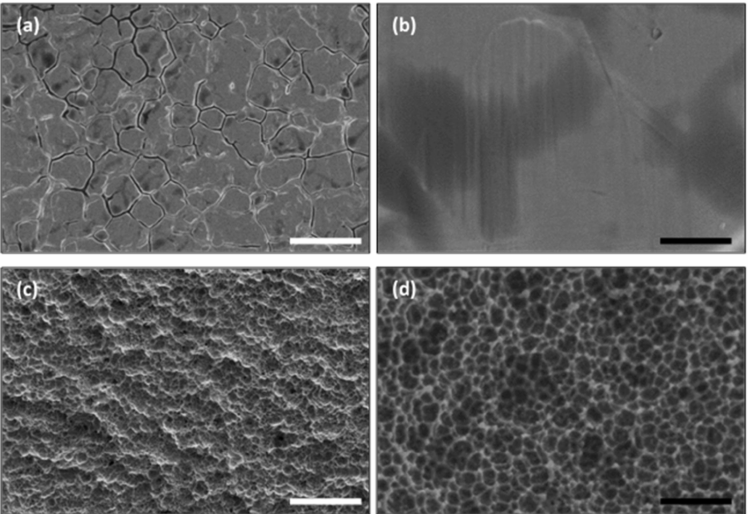
Figure 2. FE-SEM micrographs of bare stainless steel ( a , b ) and stainless steel electrochemically etched at 10 V for 10 min ( c , d ). White and black scale bars in ( a – d ) indicate 25 µ m and 500 nm,